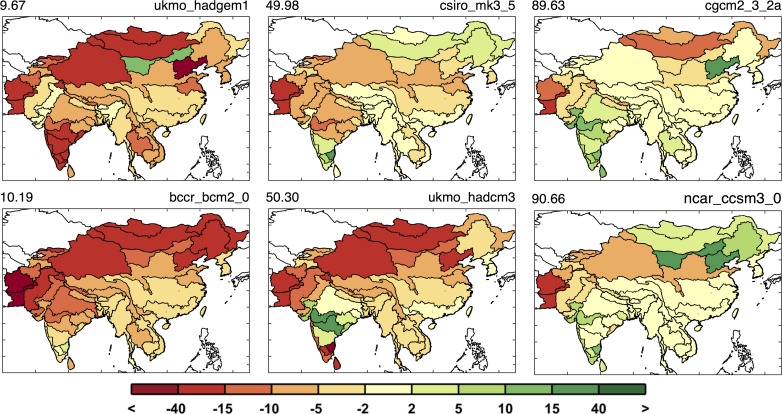
Runoff change patterns (in %) around the 10th, 50th, and 90th percentile.Two are shown for each percentile, based on the mean runoff change for the region (the metric used in Fig 10). Top label shows the percentile (left) and the GCM name (right.)